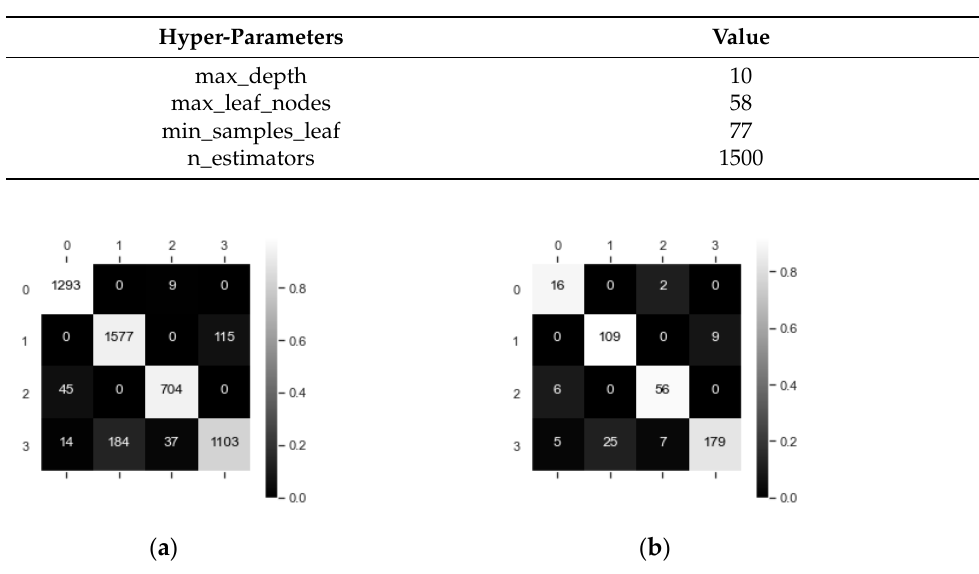
Table 8. Hyper-parameters used in Random Forest.